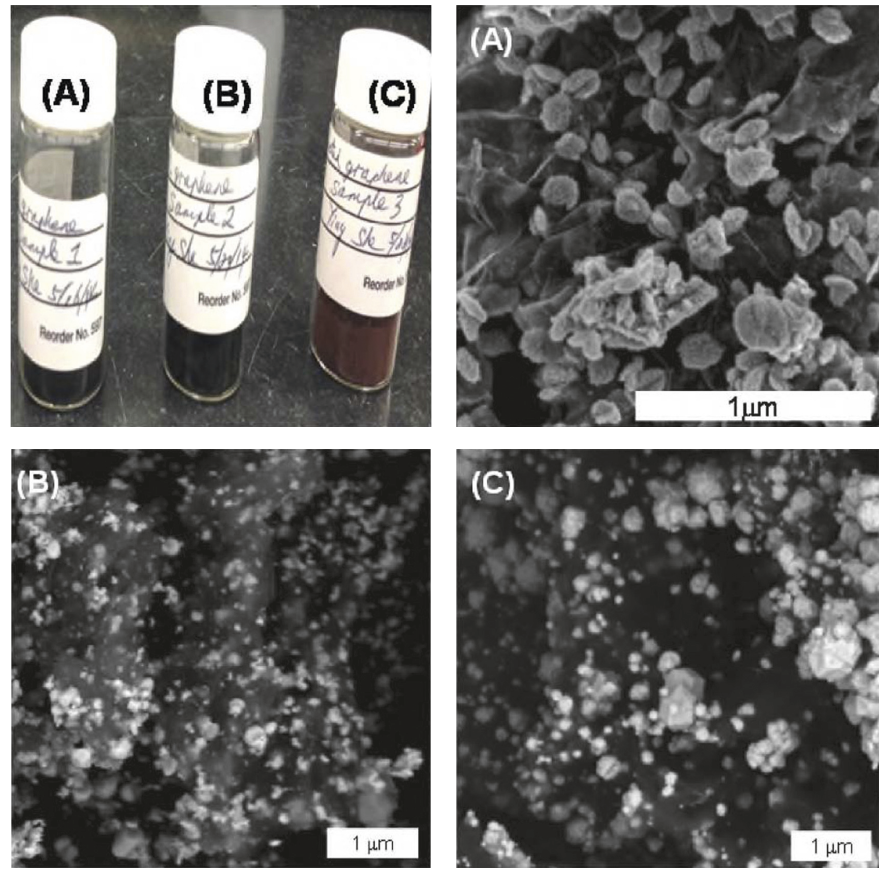
Figure 13: Morphology of the graphene-Cu MMC powders produced through electorless plating under different plating time. Digital photo of all samples, (A) plating for 1.5h, (B) plating for 3 h, and (C) plating for 4.5 h